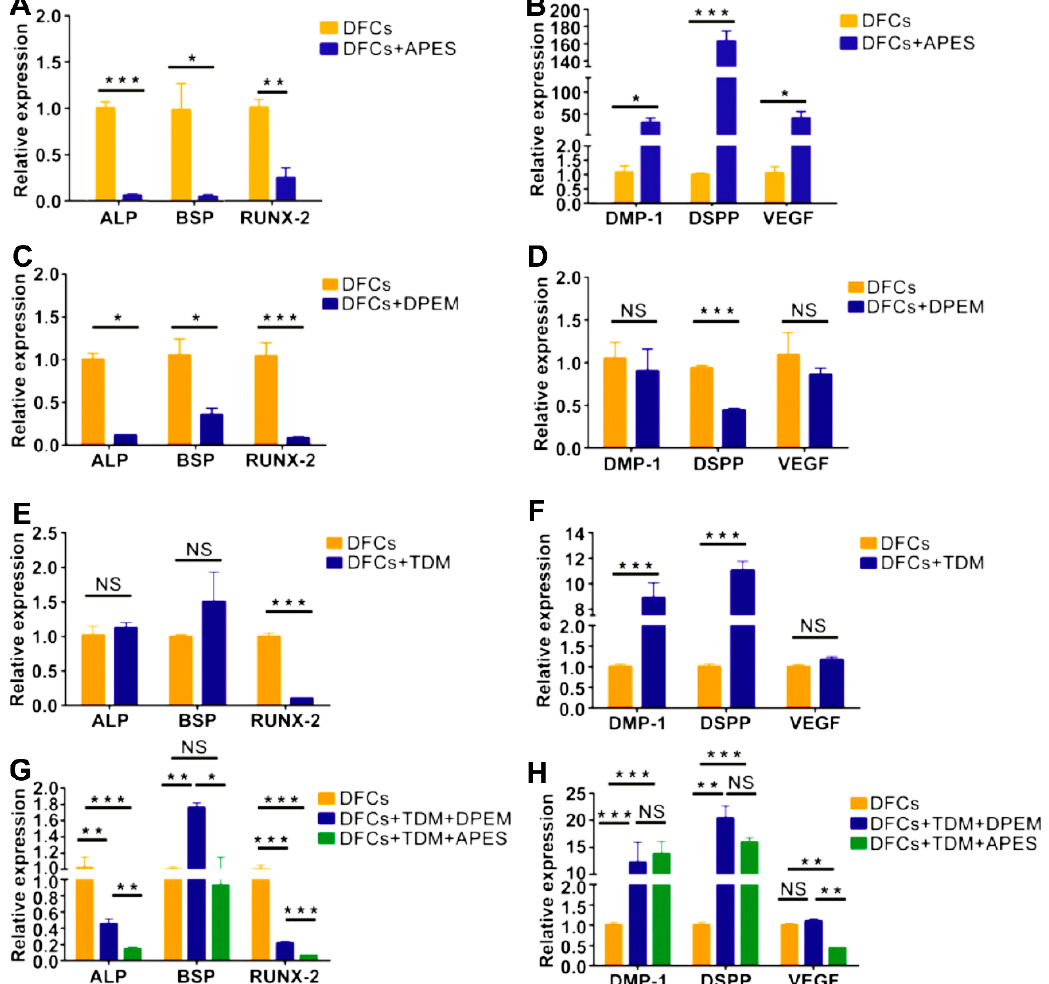
Figure 5. The combination of APES/TDM and DPEM/TDM on odontoblastic differentiation of DPSCs. ( A , B ) The APES group up-regulated DSPP and DMP-1, two classic odontogenic markers. Meanwhile, the expression of vasculogenesis and angiogenesis marker VEGF was up-regulated, but early osteogenic/odontogenic markers ALP, BSP and RUNX-2, were down-regulated. ( C , D ) In DPEM group, the expression of ALP, BSP and RUNX-2 expression were inhibited. The expression of DMP-1 and VEGF did not change. ( E , F ) In TDM group, DMP-1 and DSPP were up-regulated, but ALP, BSP and VEGF were not. ( G , H ) In the group of DPEM/TDM or APES/TDM, the expression of DMP-1 and DSPP were up-regulated, while ALP and RUNX-2 were down-regulated. Interestingly, DPEM/TDM not only up-regulated BSP, but also kept the expression level of VEGF. * p < 0.05, ** p < 0.01, *** p < 0.001, NS: no significance. (From Chen [69], Biomaterials , with